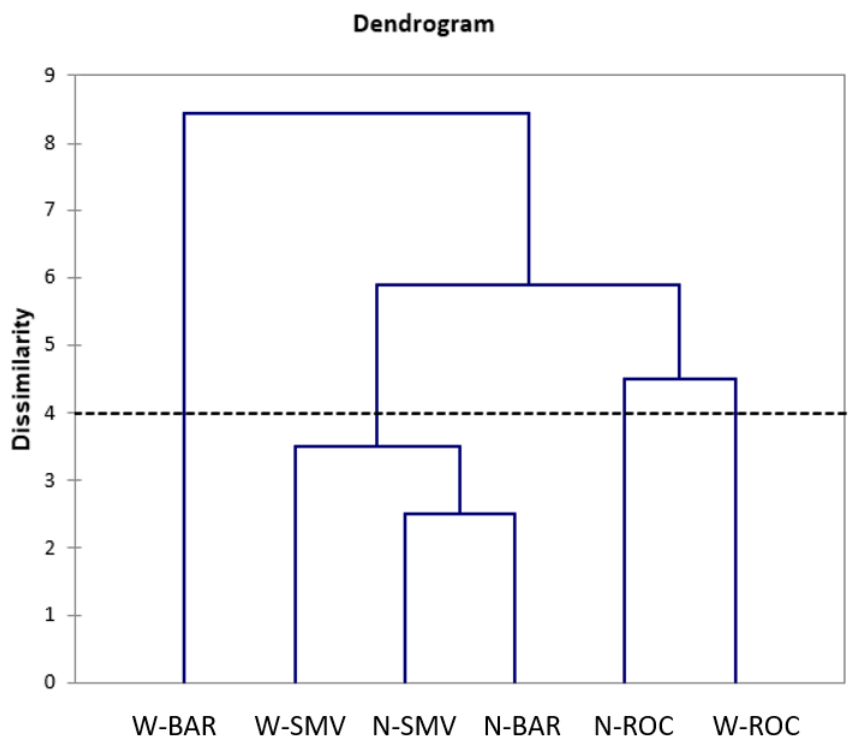
Figure 4. Agglomerative hierarchical analysis of the phototrophic component of the subaerial biofilm samples according to species composition. Dashed line indicates the cut-off point in the clustering of samples.